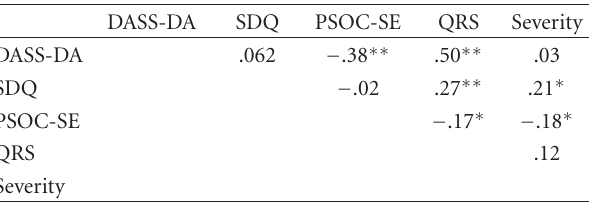
Table 2: Intercorrelations of primary variables of interest.